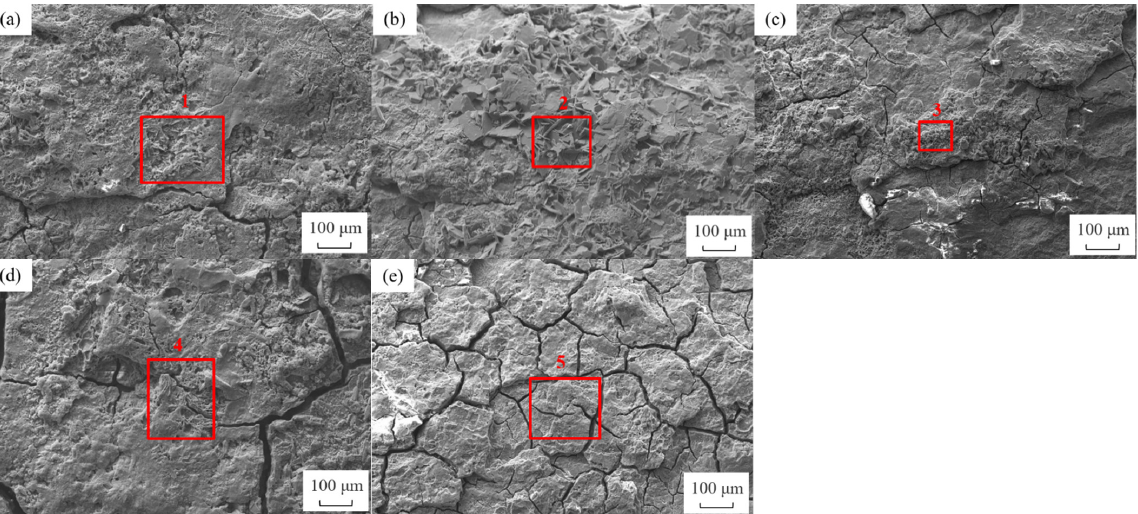
Figure 9. SEM morphology of the hot dip coating after 120 d corrosion with different process parameters, ( a ) 450-30-W; ( b ) 450-45-W; ( c ) 475-30-W; ( d ) 475-45-W; ( e ) 450-30-A. Table 10. Elemental composition (wt%) of the surface of the hot dip coated steel wire after 120 d corrosion with different process parameters.